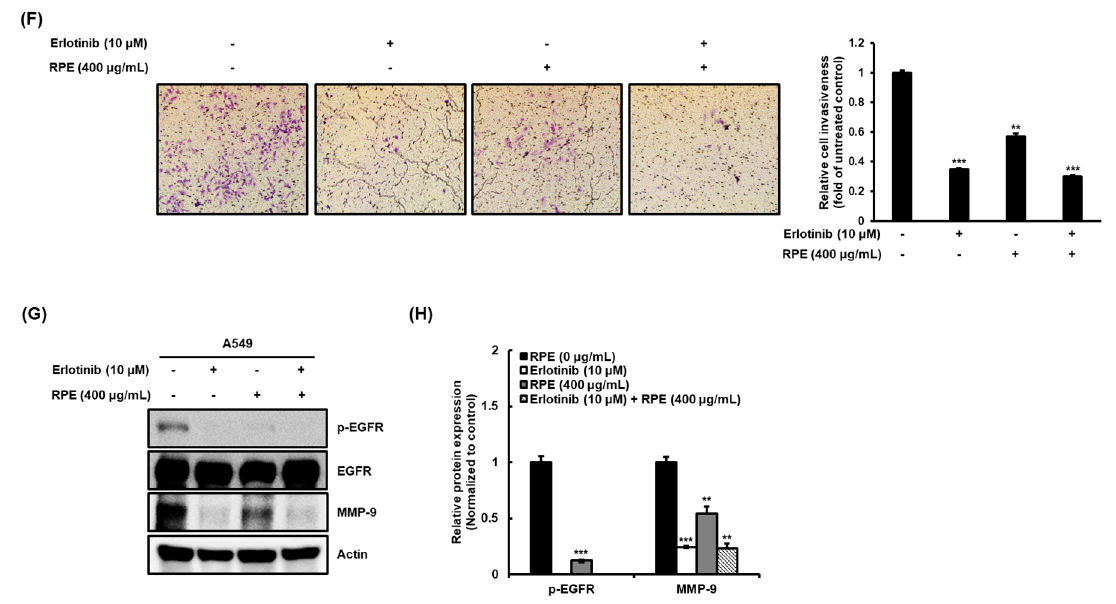
Figure 4. RPE suppresses proliferation, migration, and invasion by EGFR-c-Raf-MEK and mTOR-Akt signaling pathways. ( A ) Scratched A549 cells were treated with RPE for 24 h, and then the wound healing area was photographed and measured with the Image J program. ( B ) The cells that invaded through the extracellular matrix-like membrane were measured with the Matrigel invasion assay. ( C ) Activities of MMP-2 and MMP-9 were detected by zymography and ( D ) expression of those were measured with Western blotting analysis. Representative bands are indicated. ( E ) Wounded A549 cells were treated with erlotinib or RPE for 24 h, and then the migrated area was photographed and measured with the Image J program. ( F ) The invasive cells were measured with the Matrigel invasion assay. Size of the scale bar in the images refer to 100 µ m. ( G ) The expression of p-EGFR, EGFR, and MMP-9 was determined by Western blotting and ( H ) densitometric analysis. β -actin was used as loading control. Relative motility, invasiveness or expression are represented as means ± standard deviation ( n = 3) as * p < 0.05, ** p < 0.01, *** p < 0.005, compared with untreated group.